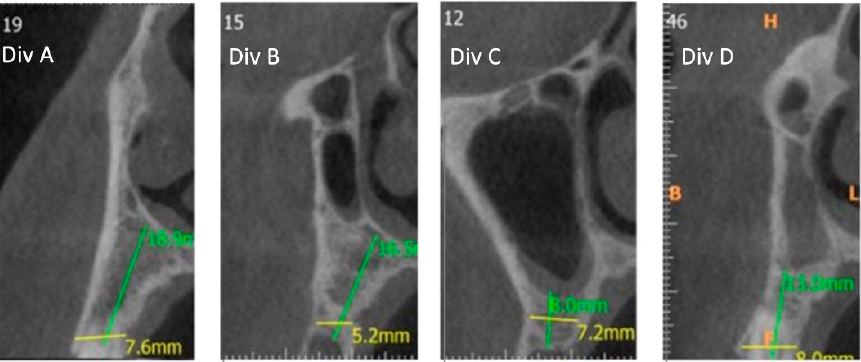
Figure 4. From left to right—CBCT cross sections: Division A (Div. A): Nasal cavity alone; Division B (Div. B): Nasal cavity in adjacent to sinus cavity; Division C (Div. C): Sinus cavity alone above the alveolar ridge; Division D (Div. D): Nasal cavity is positioned superiorly to sinus cavity.